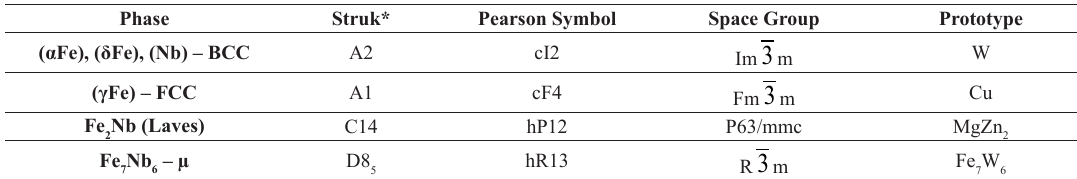
Table 1. Crystallographic information for stable solid phases in the Fe-Nb system [ 27,28